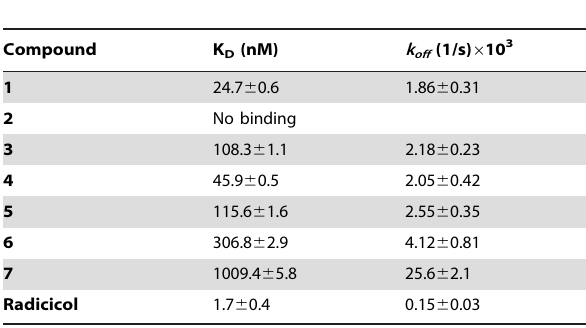
Table 1. Thermodynamic and kinetic constants measured by SPR for the interaction between tested compounds and immobilized HSP90.